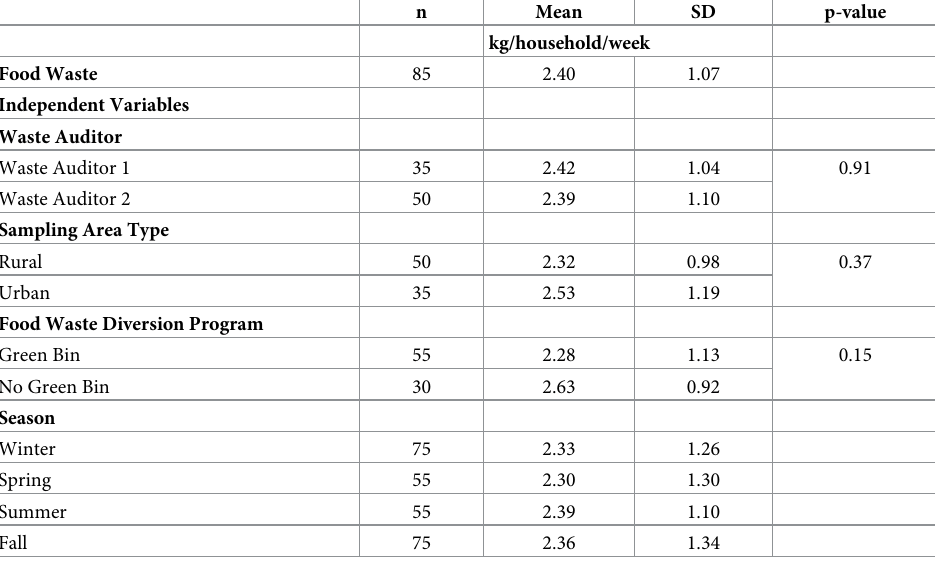
Table 1. Average weekly food waste disposal for southern Ontario households and impact of waste auditor, sam- pling area type, access to food waste diversion programs and